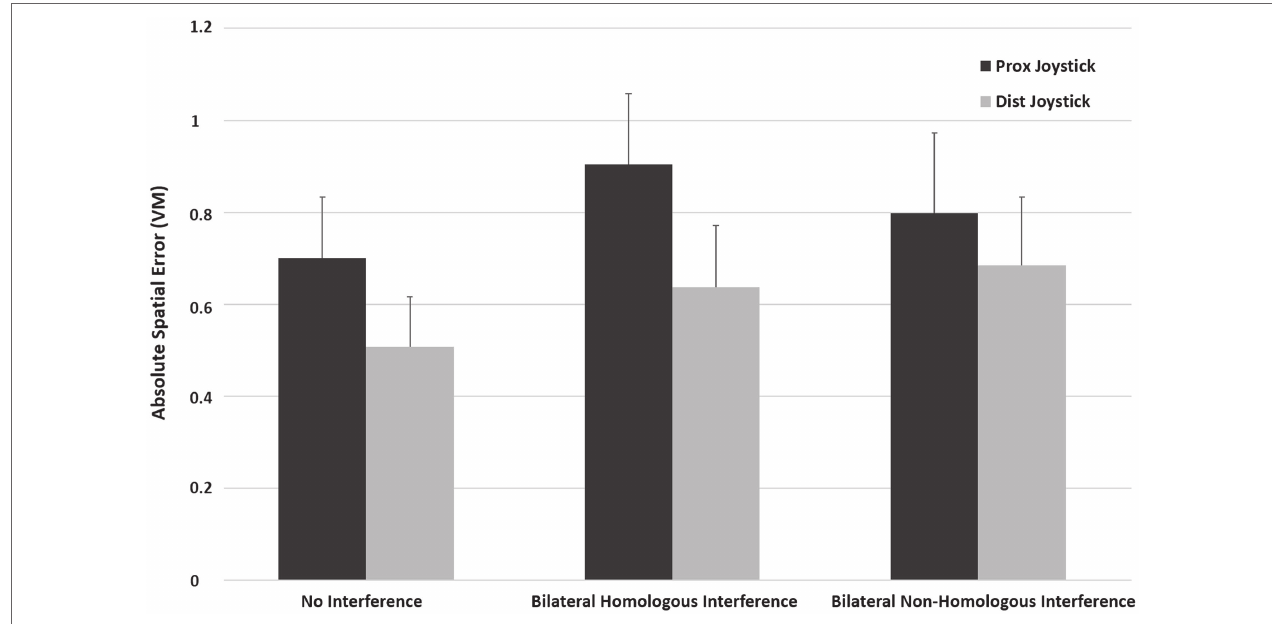
FIGURE 4 | Mean ASE for the proximal- and distal-controlled joystick under conditions of no interference, homologous interference, and non-homologous interference. The error bars illustrate SD